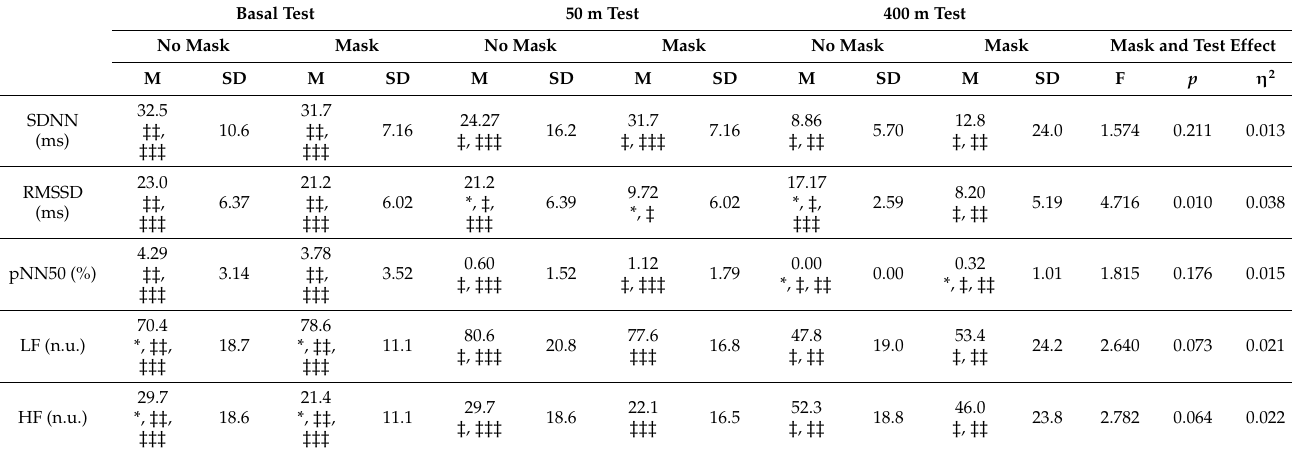
Table 2. Heart rate variability modifications in the 50 m and 400 m tests with and without mask. Basal